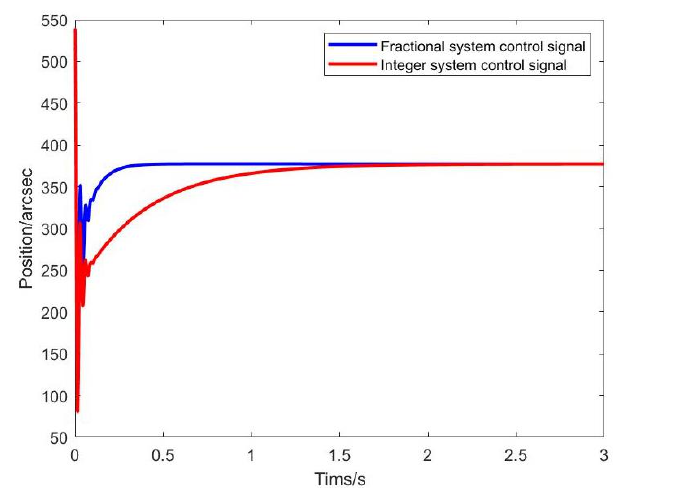
Figure 12. Control signal of fractional/integer-order